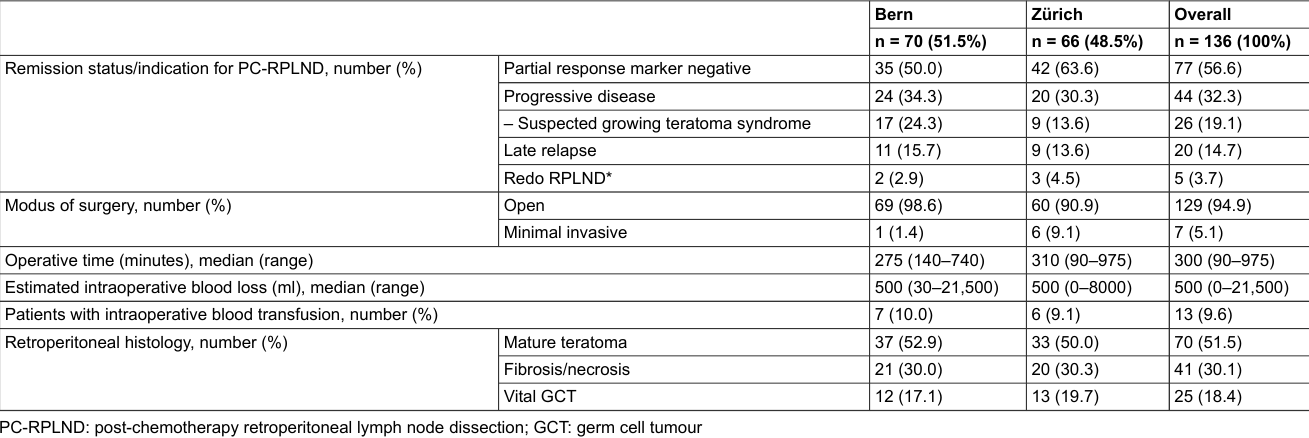
Table 2: Surgical data post-chemotherapy retroperitoneal lymph node dissection. Remission status/indication for PC-RPLND, number (%)